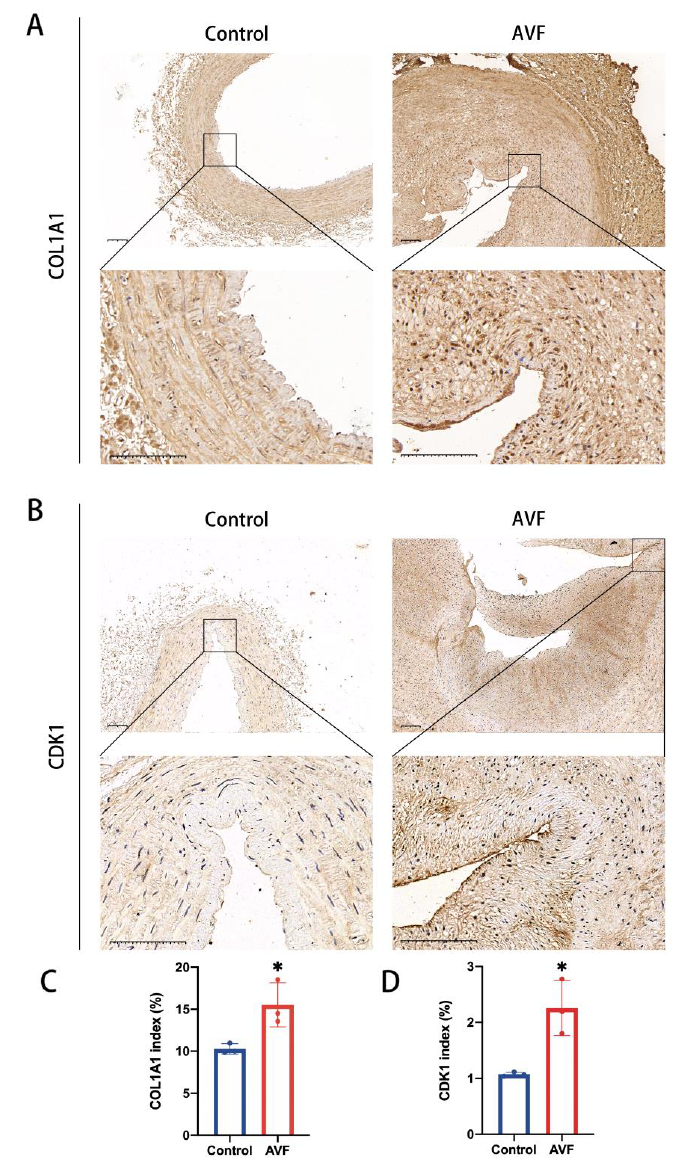
Figure 10. Validation of hub genes in clinical samples. ( A ) Immunohistochemical staining for COL1A1 in the native vein and AVF venous sample of a male CKD patient (N = 3). ( B ) Immunohistochemical staining of CDK1 in the native vein and AVF venous sample of a male CKD patient (N = 3). ( C ) The quantitative analysis of COL1A1 in the native vein and AVF venous sample of a male CKD patient. ( D ) The quantitative analysis of CDK1 in the native vein and AVF venous sample of a female CKD patient. Cells staining brown are positive for COL1A1 and CDK1. Two-sample t test was performed. Each bar represents mean ± SD. Significant differences are indicated by * p < 0.05. Scale bar is 100 µ m. COL1A1 indicates collagen type I alpha 1; AVF, arteriovenous fistula; CDK1, cyclin-dependent kinase